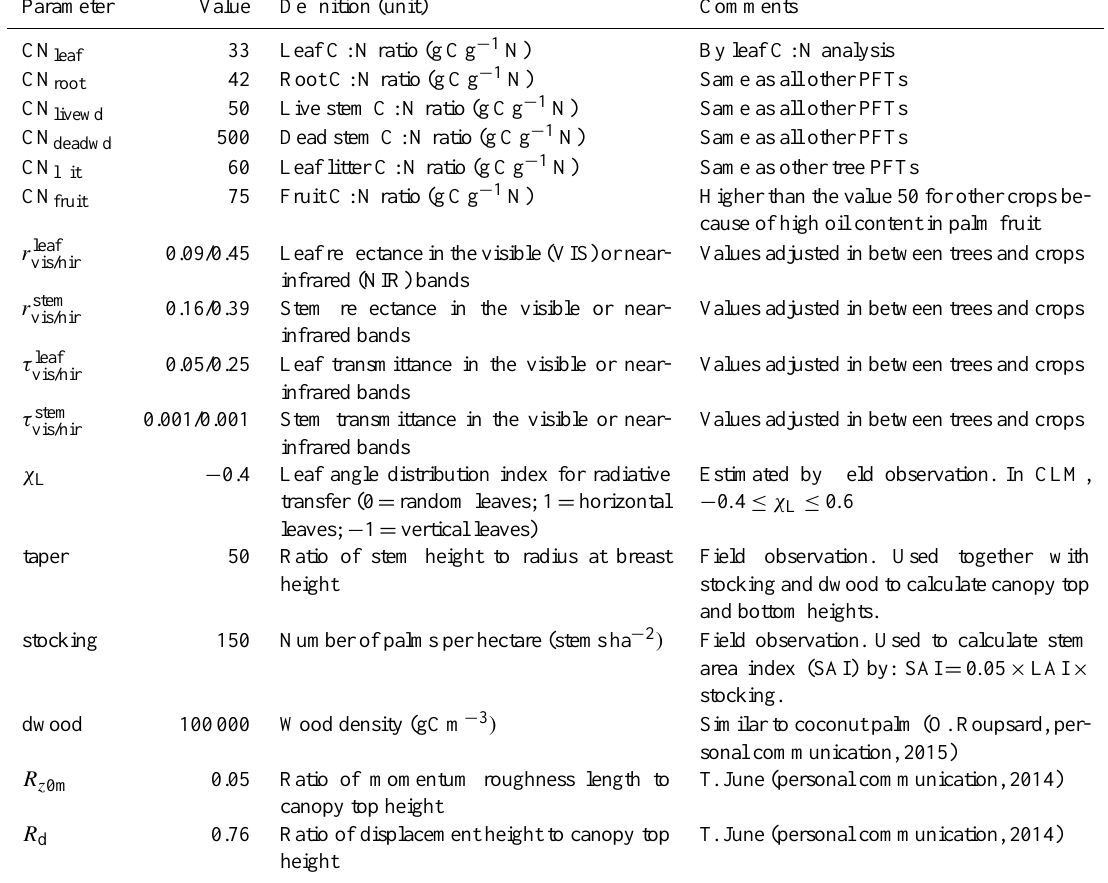
Table A3. Other optical, morphological, and physiological parameters for oil